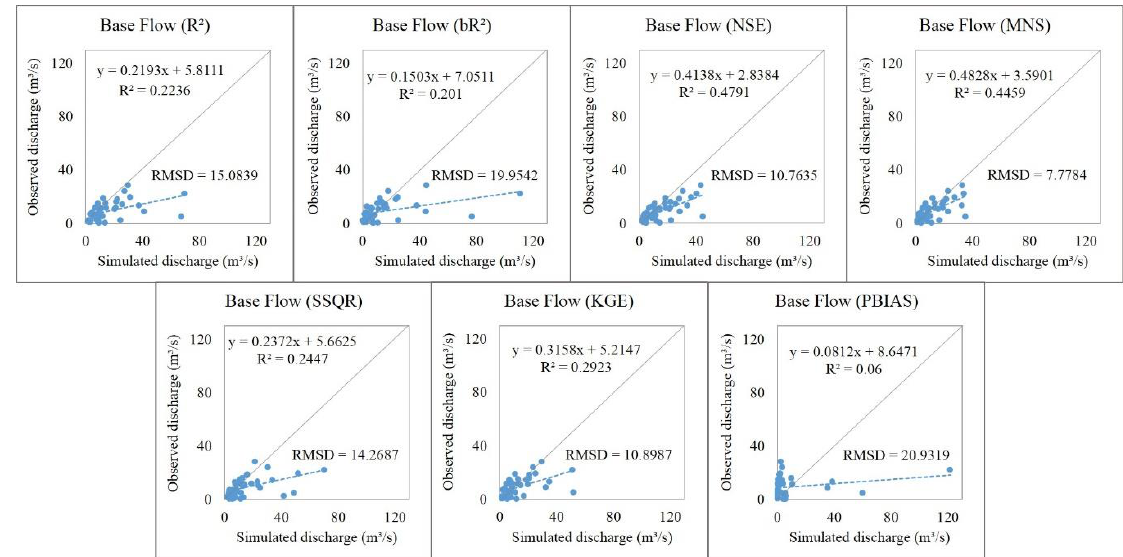
Figure 8. Scatter plots of simulated versus observed base flows for different objective functions.